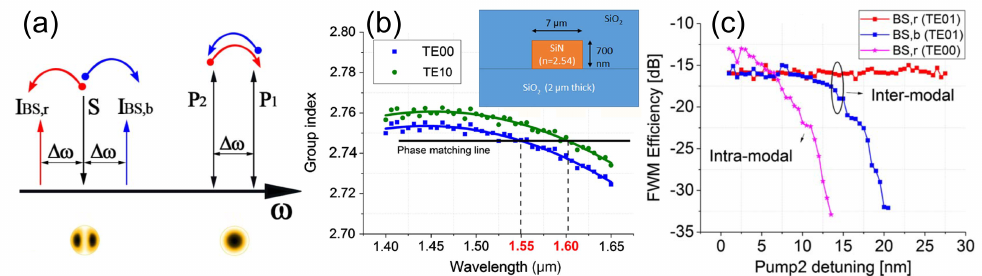
Figure 6. ( a ) Operation principle of the dual-pump IM-BS-FWM process: energy is transferred directly from the signal (S) to two idlers ( I BS , r and I BS , b ) and between the two pumps ( P 1 and P 2 ). ( b ) Numerically simulated group index curves for a Si-rich SiN waveguide (n = 2.54 at 1550nm), with the waveguide cross-section shown in the inset. ( c ) BS-FWM efficiency measured as a function of pump P 2 detuning for the intermodal and intramodal configurations. Reproduced from [40] under a CC BY 4.0